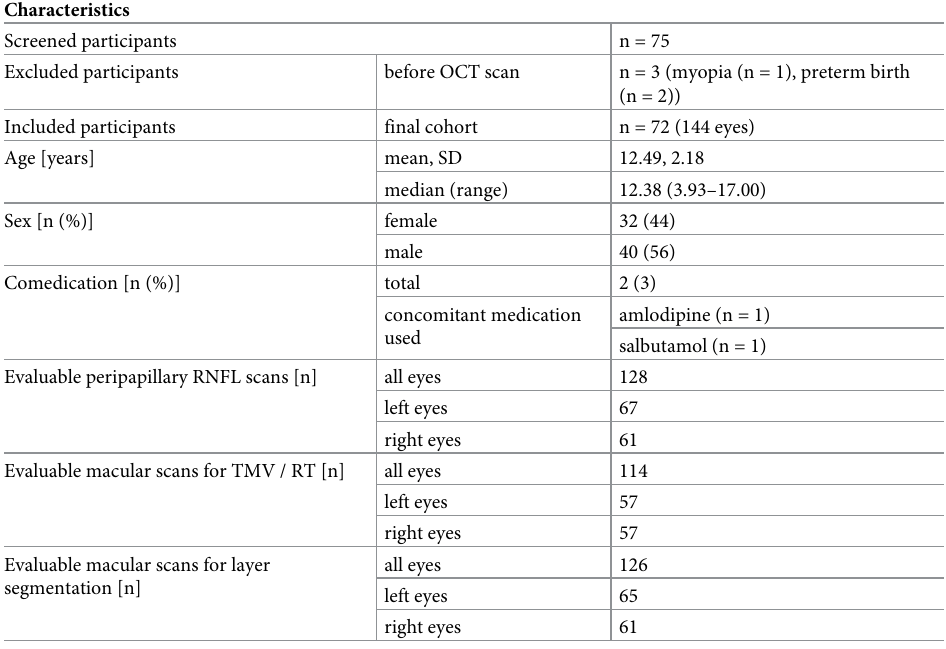
Table 2. Summary of participant characteristics.